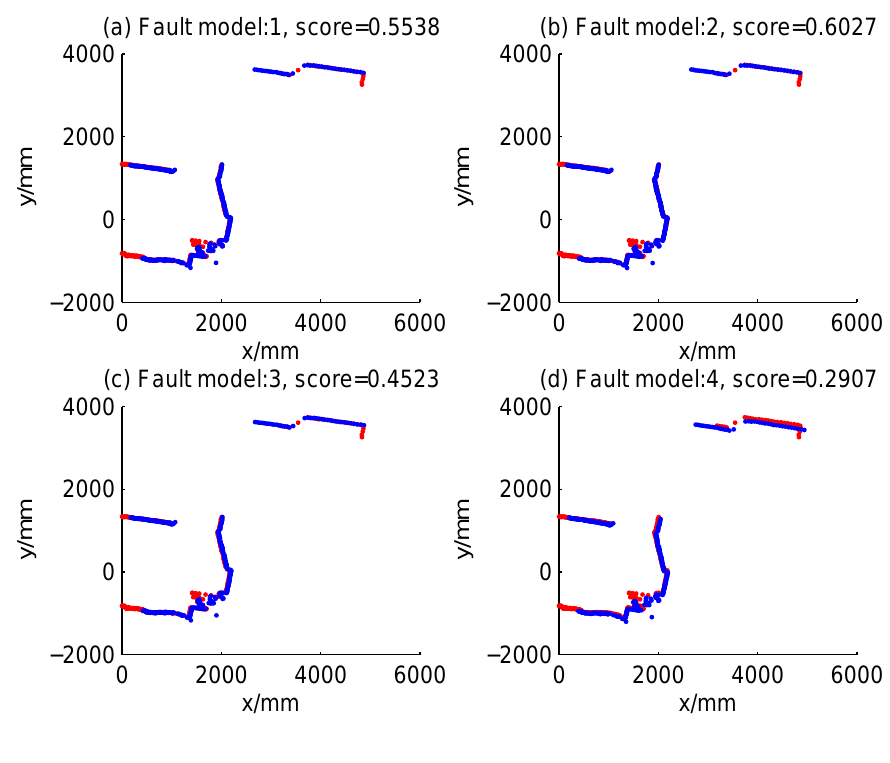
Figure 10. Case 1b: No faults, fault model = 1 (time Step 3).